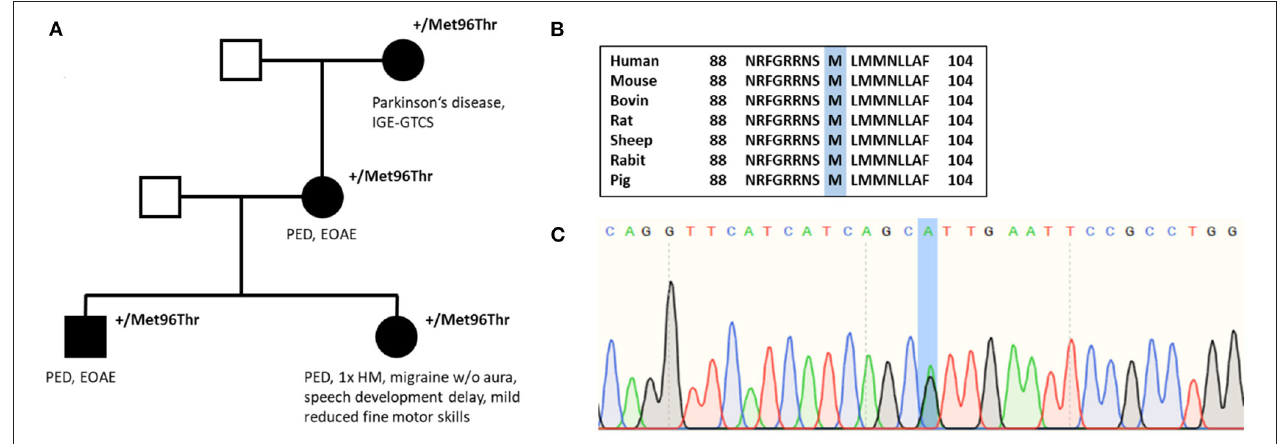
FIGURE 2 | (A) Pedigree of individual #3 shows autosomal dominant inheritance. (B) Amino acid sequence alignment of SLC2A1 across several species demonstrates conservation of the Met96 residue. (C) Nucleotide sequence with substitution of A with G (c.286A > G).